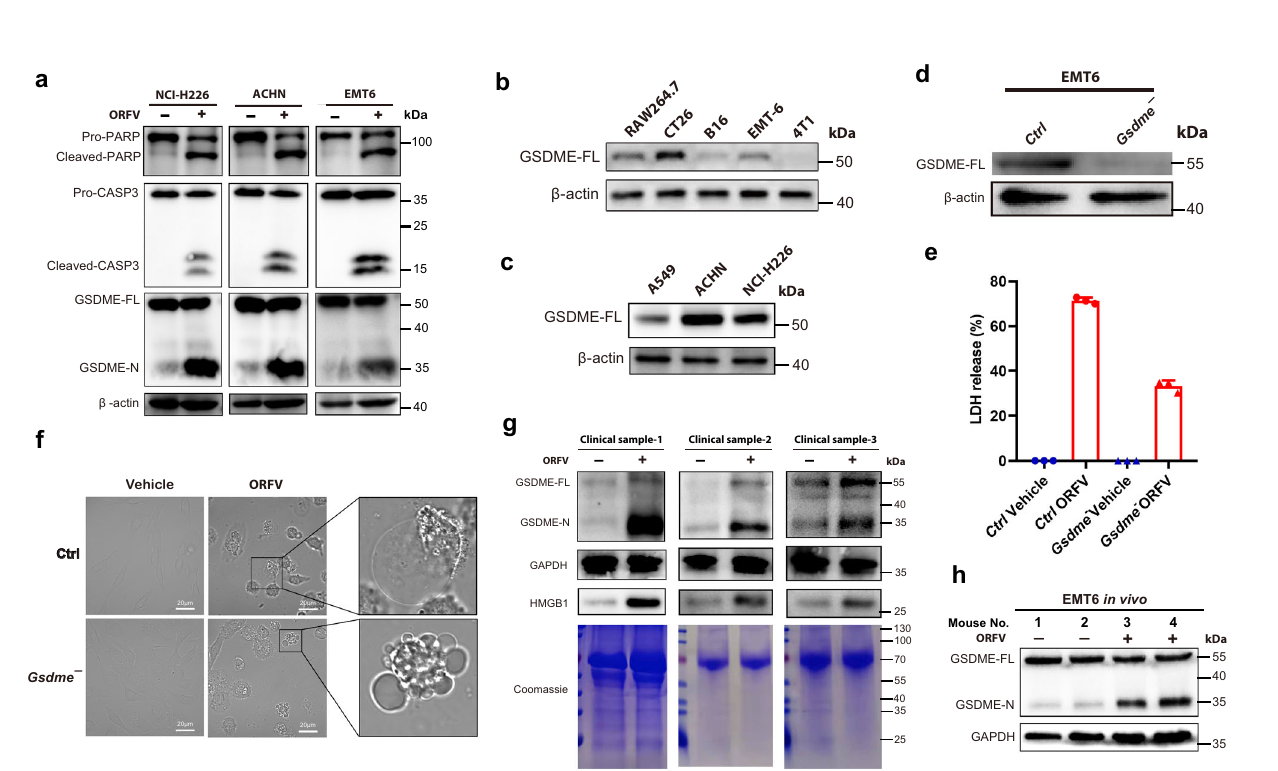
Fig. 1 | ORFV triggerstumor pyroptosis.a Schematic illustration ofexperimental design. Mice were engrafted with murine tumor cells, followed by intratumorally (i.t.) ORFV challenge. Tumor volume, intratumoral lytic cell death, and pro- in fl ammatorysignalingweredetermined.Humantumortissuesandtumorcelllines were treated with ORFV for indicated time points, then cell morphology, pro- in fl ammatory mediators, and molecular test were performed. b Six weeks old femaleBALB/cmiceweres.c.engraftedwithEMT6cells(1×10 6 cells/mouse)andi.t. treated with ORFV (1×10 5 TCID 50 /mouse) ( n =8 – 10) ( P <0.0001). c RT-qPCR ana- lysisfromORFVorvehicle-treatedEMT6tumortissues( n =3).RelativemRNAlevel changes of selected in fl ammatory genes were displayed ( NLRC4 : P =0.0041, Gsdmd : P =0.0130, IL-18 : P =0.0416, IL-6 : P =0.0123, IL-1 β : P =0.0071 , Caspase-1 : P =0.0005, Caspase-8 : P =0.0048). d Images acquired with a fl uorescence